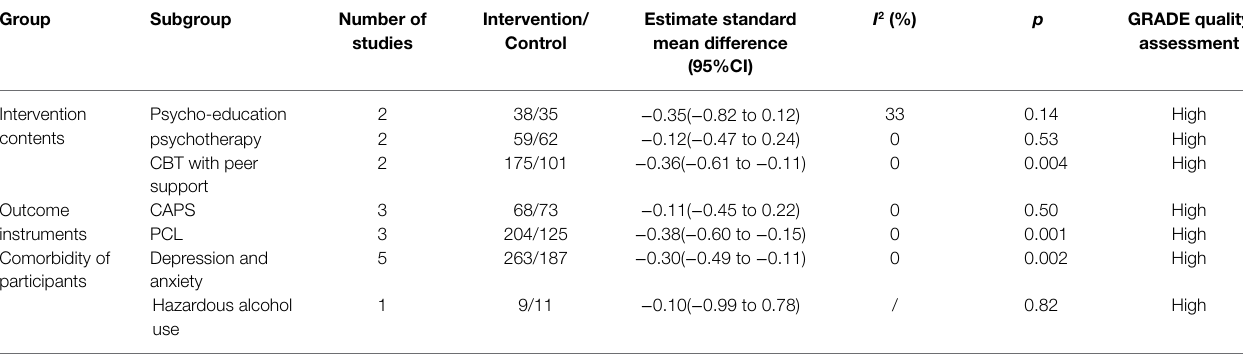
TABLE 3 | Summary of subgroup analysis on intervention contents, outcome instruments, and comorbidity of participants.